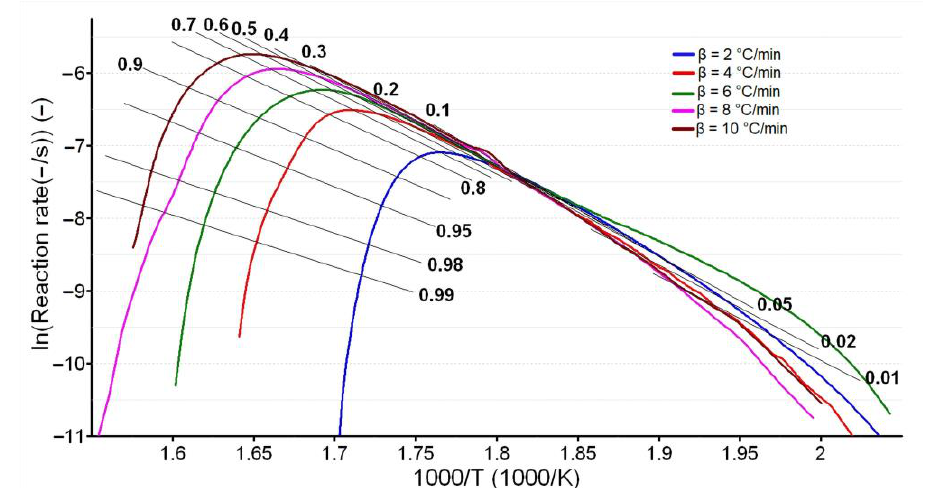
Figure 7. Friedman’s linear plotting for decomposition of EE.